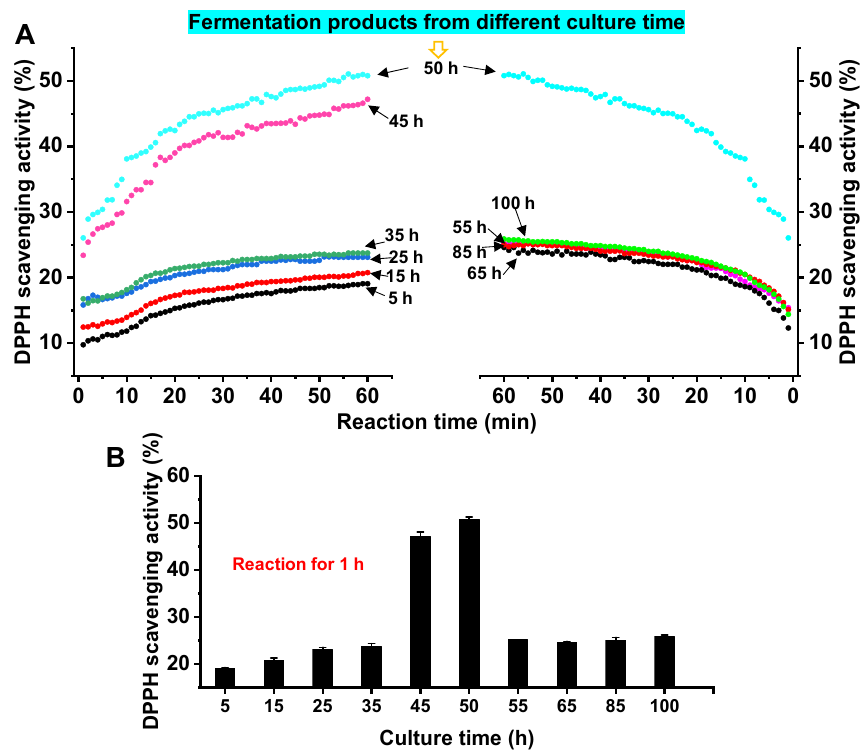
Figure 5. Kinetics of DPPH scavenging activity of fermentation products from two culture periods during the reaction time of 1 h, ( A ) the period of 0 h to 50 h, and ( B ) the period of 50 h to 100 h. ( C ) DPPH scavenging activity of fermentation products during the culture of strain QZ9-9 after 1 h reaction. Note: The reaction time refers to the time consumed by the combination reaction between fermentation products and DPPH